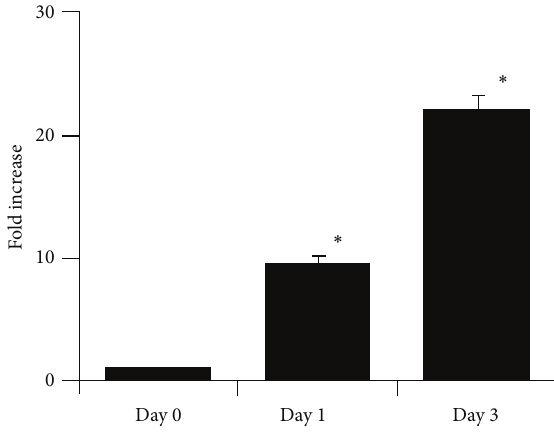
Figure 1: Fold increases of total cell numbers in peritoneal exudate during thioglycollate treatment in vivo . C57BL/6 mice (males) were treated with thioglycollate as described in Section 2. At three timepoints, before (day 0) and after (day 1 and 3) the treatment, peritoneal exudate cells were isolated and counted as described in Section 2. Fold increases were calculated as the cell number at a timepoint divided by the cell number on day 0 (defined as 1). Values are presented as the means ± SE. 𝑛 = 3 -4 per timepoint. ∗ 𝑃 < 0.001 versus day